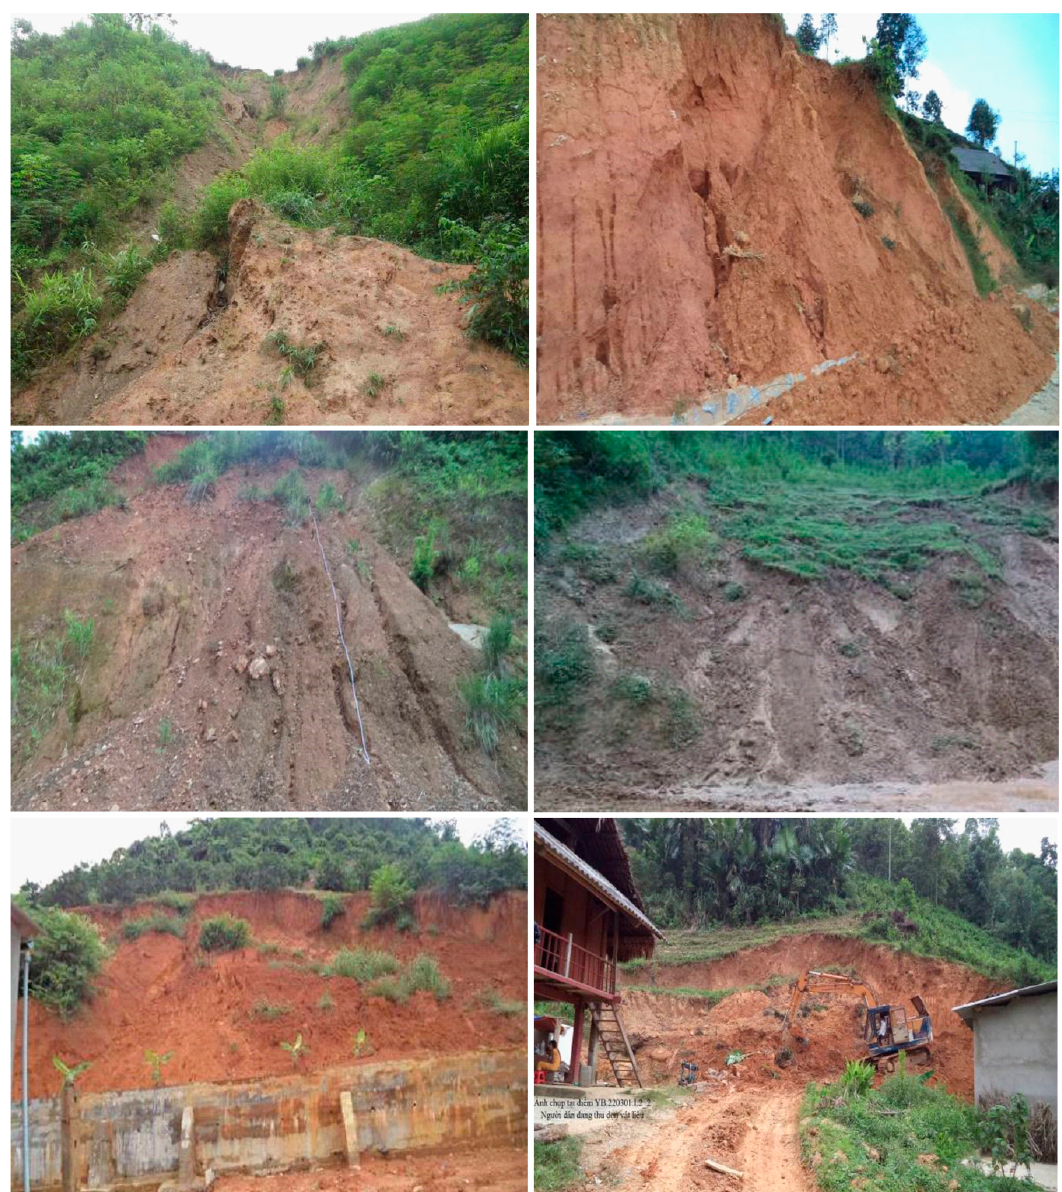
Figure 3. Photos of landslides in the Van Chan district (Photographs by Thai Minh Hai, Vo Nguyen Thien, and Nguyen Van Phu).